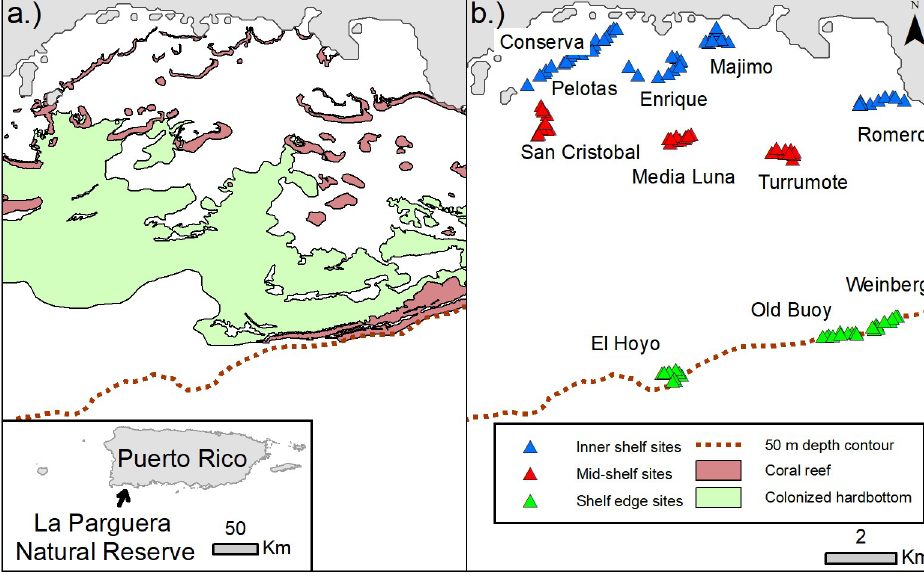
Fig 2. Maps of the LPNR study area. (a) Colonized hardbottom and coral reef habitat extent with 50-meter depth contour and (b) survey sites within each experimental zone (inner-shelf, mid-shelf,